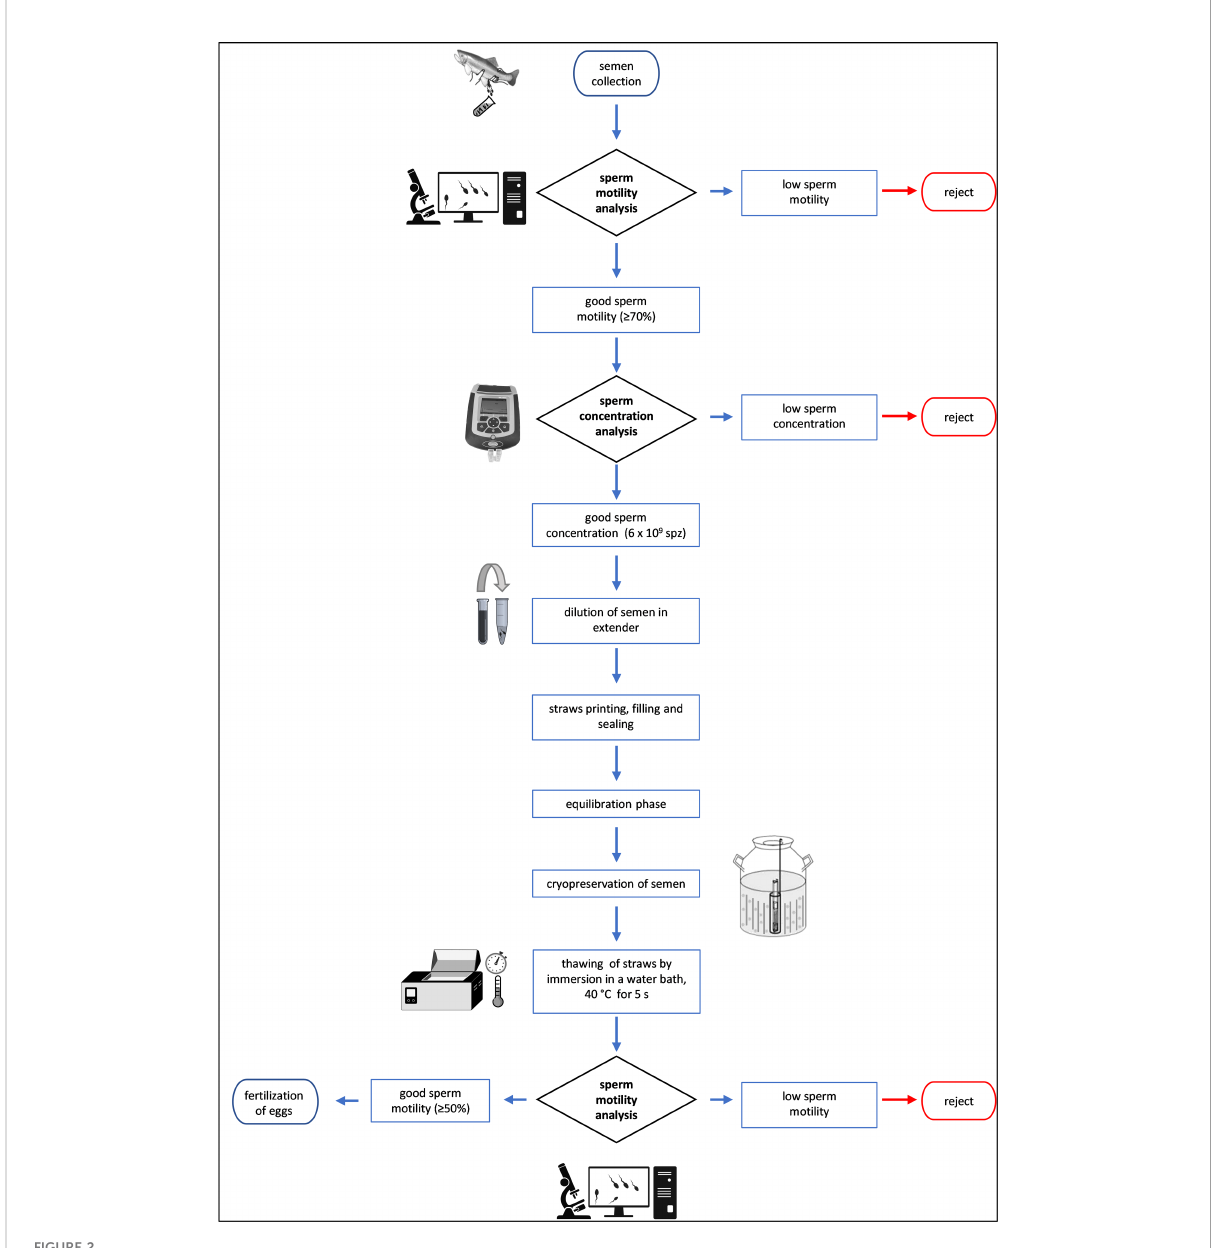
FIGURE 2 Flow chart of operations from semen collection to egg